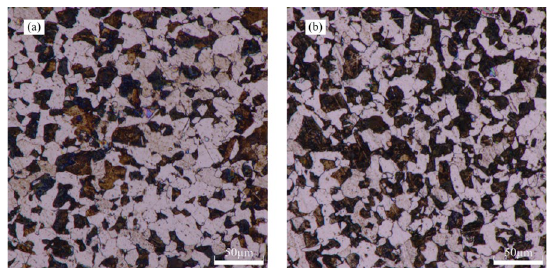
Figure 20 The metallographic microstructure of the machined surface (convex and concave)